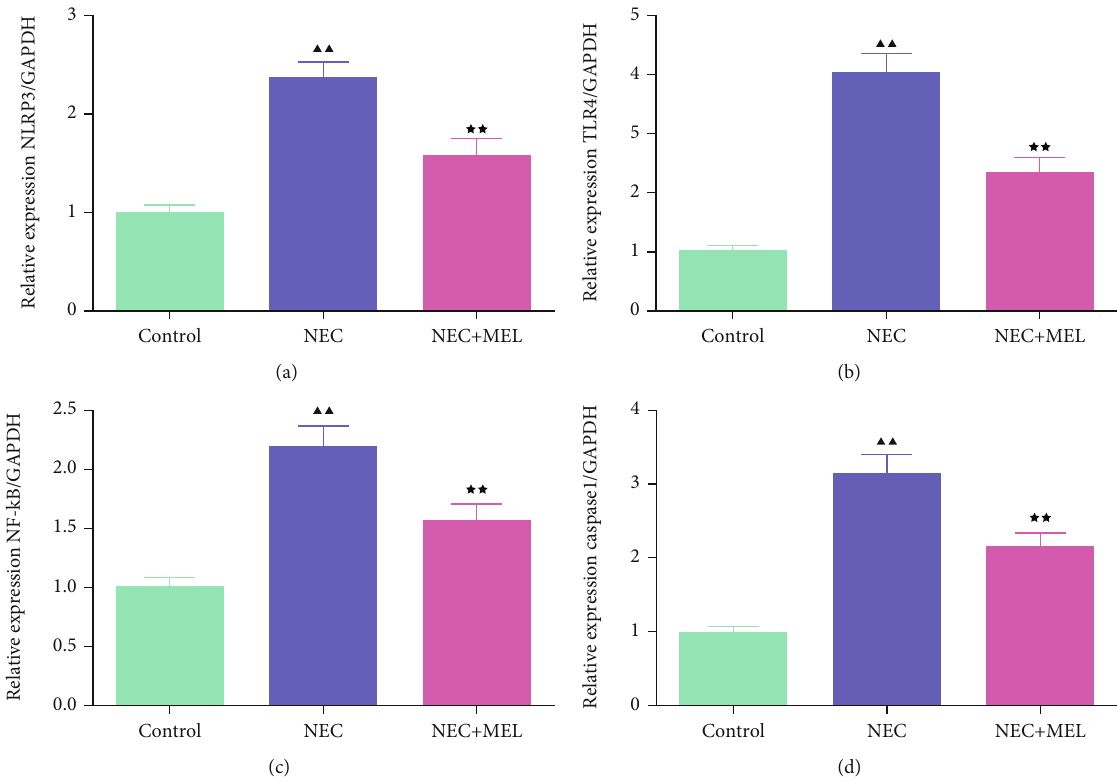
Figure 5: MEL attenuated the mRNA levels of NLRP3, TLR4, NF- κ B, and caspase-1 of the terminal ileum tissues in NEC mice. (a – d) The e ff ect of MEL on the mRNA levels of NOD-like receptor family pyrin domain containing 3 (NLRP3), Toll-like Receptor 4 (TLR4), NF-kappaB (NF- κ B), and caspase-1 of the terminal ileum tissues in NEC mice was estimated by quantitative real-time PCR (qRT-PCR). ▲▲ P < 0 : 01 vs. control; ★★ P < 0 : 01 vs.